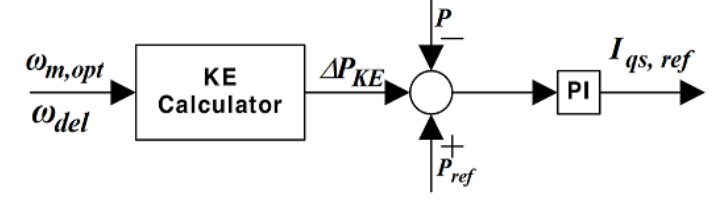
Figure 7. Kinetic energy (KE) discharge controller.